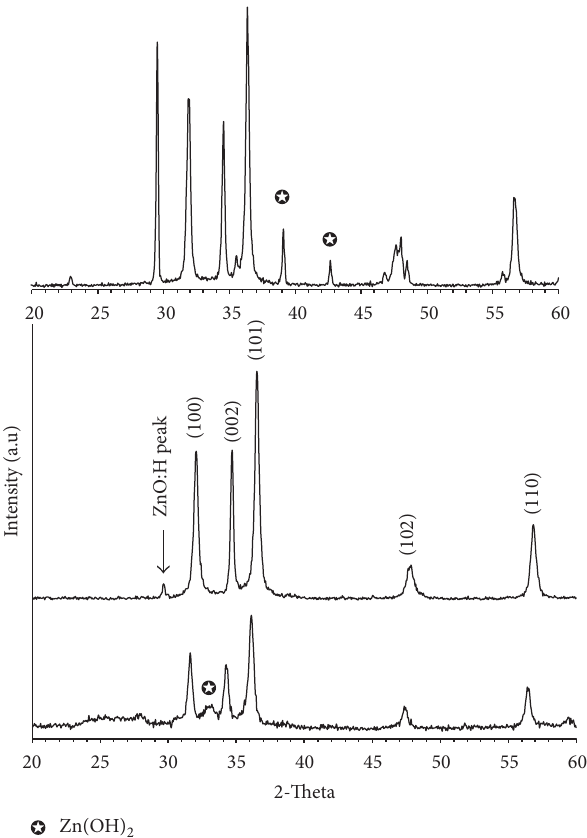
Figure 2: XRD patterns of 0.02% starch-mediated (ZnO-bottom, ZnO:H ( a ) -middle, and ZnO:H ( b ) -top) samples, respectively.